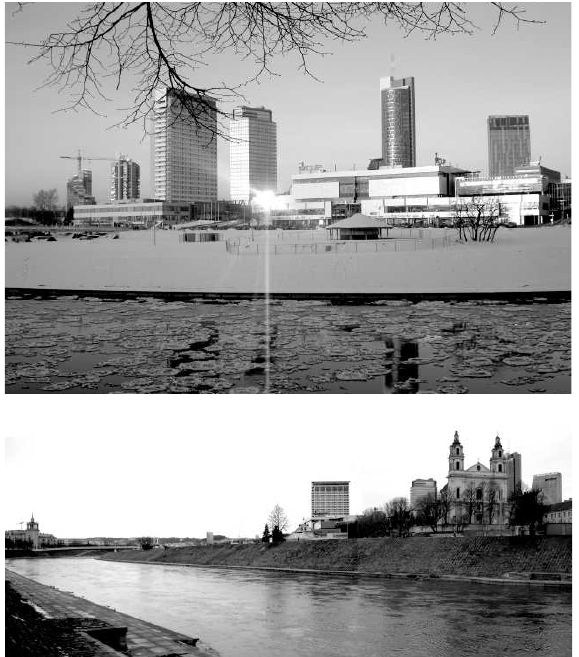
Fig 2. View of the right bank of the Neris. A. Vyšniūnas’ photos,